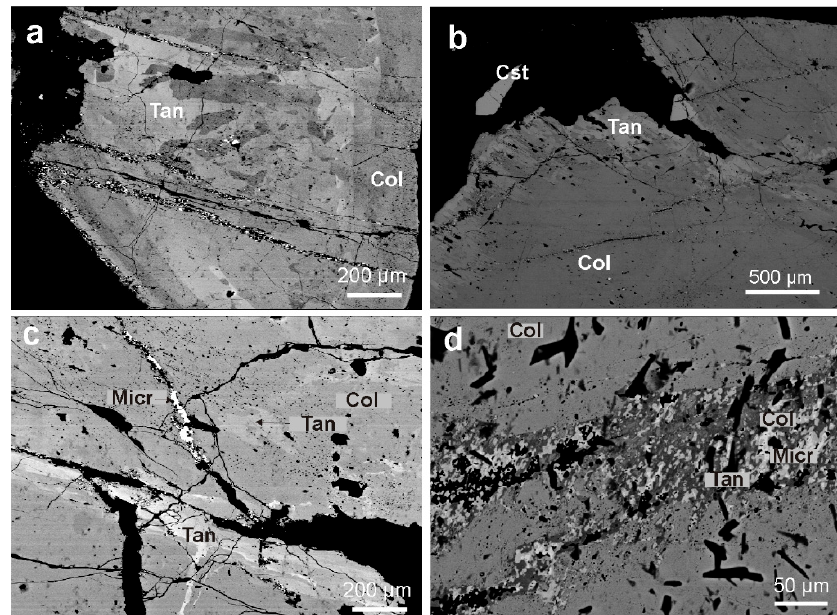
Figure 13. Textural patterns of Nb-Ta minerals from type-V pegmatites. SEM images, mode BSE. ( a ) fine-grained microlite (bright dot areas) in veins developed in a CGM crystal with patchy zoning, with Ta-rich areas (Tan) and Nb-rich ones (Col). ( b ) detail of a late replacement of columbite (col) by tantalite (tan), ( c ) microlite (Micr) and tantalite (tan) veins in CGM crystal with patchy zoning (col, columbite; tan, tantalite); ( d ) detail of the vein filling and replacement of a columbite crystal (Col) by tantalite (tan), microlite (Micr) and Ta-poor columbite (Col).